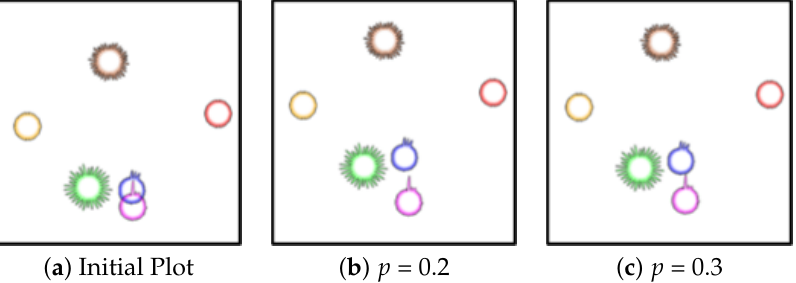
Figure 9. Overlap removal according to permitted overlap ratio p